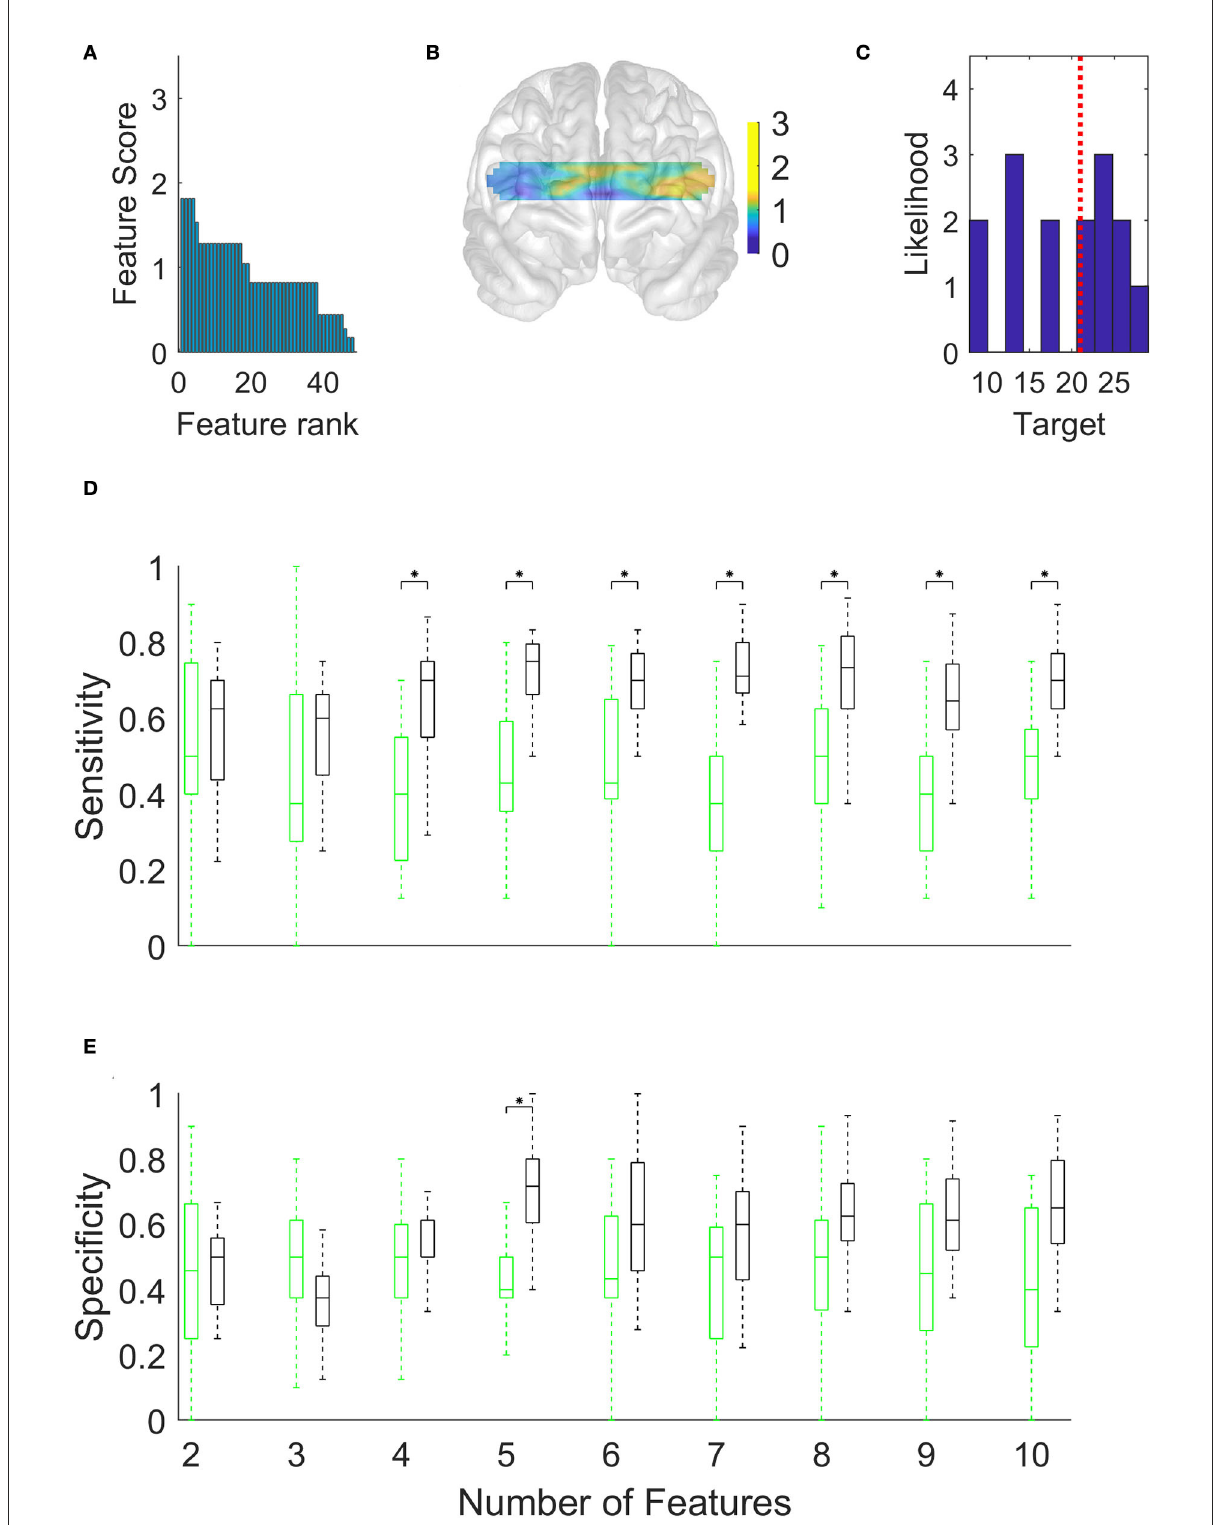
FIGURE4 Discrimination of high-scoring patients (N = 8) from low-scoring patients (N = 7) in the Boston Naming Test, using the Support Vector Machine and a limited number (x-axis in D and E ) of the top-ranked hemodynamic features. (A) Hemodynamic feature priority scores calculated using chi-squared tests. (B) Topographic distribution of feature scores. (C) Histogram of Boston Naming Test scores of patients. The vertical dotted red line shows the location of the median score used to distinguish high-scoring patients from low-scoring patients. (D) Sensitivity of discriminating high-scoring patients. (E) Specificity (*p < 0.05, Bonferroni